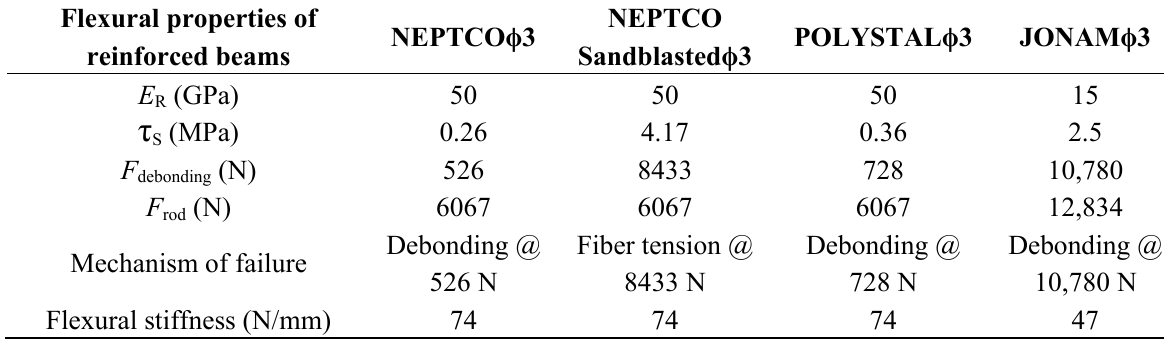
Table 3. Mode of failure of pultruded rod reinforced